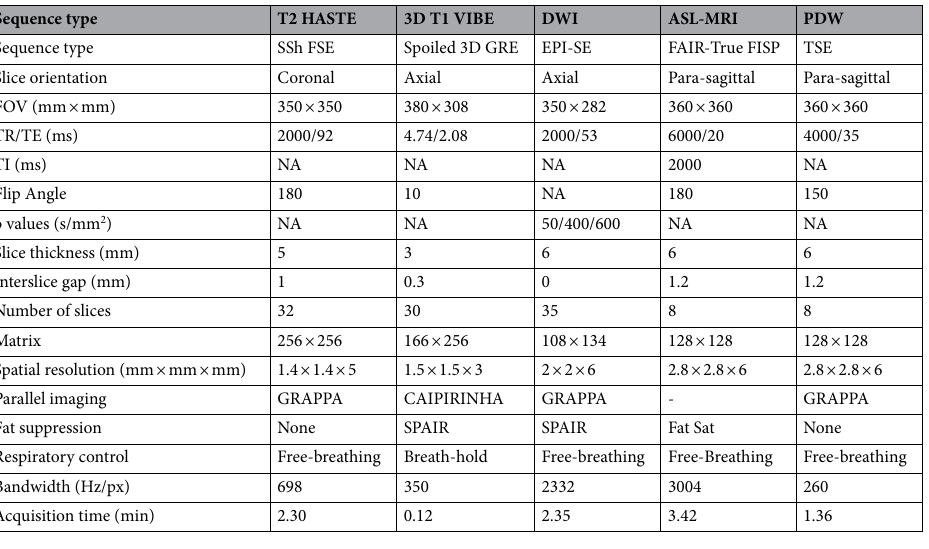
Table 2. MRI parameters of the used sequences. HASTE—Half-Fourier Single-Shot Turbo Spin-Echo; VIBE— Volumetric Interpolated Breath-hold Examination; DWI—Diffusion-Weighted Imaging; ASL—Arterial Spin Labeling; PDW- Proton Density-Weighted; SSh FSE—Single-Shot Fast Spin-Echo; GRE—Gradient Echo; EPI SE—Echo-Planar Imaging Spin-Echo; FAIR True-FISP—Flow-sensitive Alternating Inversion Recovery True-Fast Imaging with Steady-State Precision; FOV—Field of View; TR—Repetition Time; TE—Echo Time; TI—Inversion Time; GRAPPA—Generalized Autocalibrating Partial Parallel Acquisition; CAIPIRINHA— Controlled Aliasing in Parallel Imaging Results in Higher Acceleration; GRASE- Gradient and Spin Echo; SPAIR—Spectral Attenuated Inversion Recovery; Fat Sat—Fat